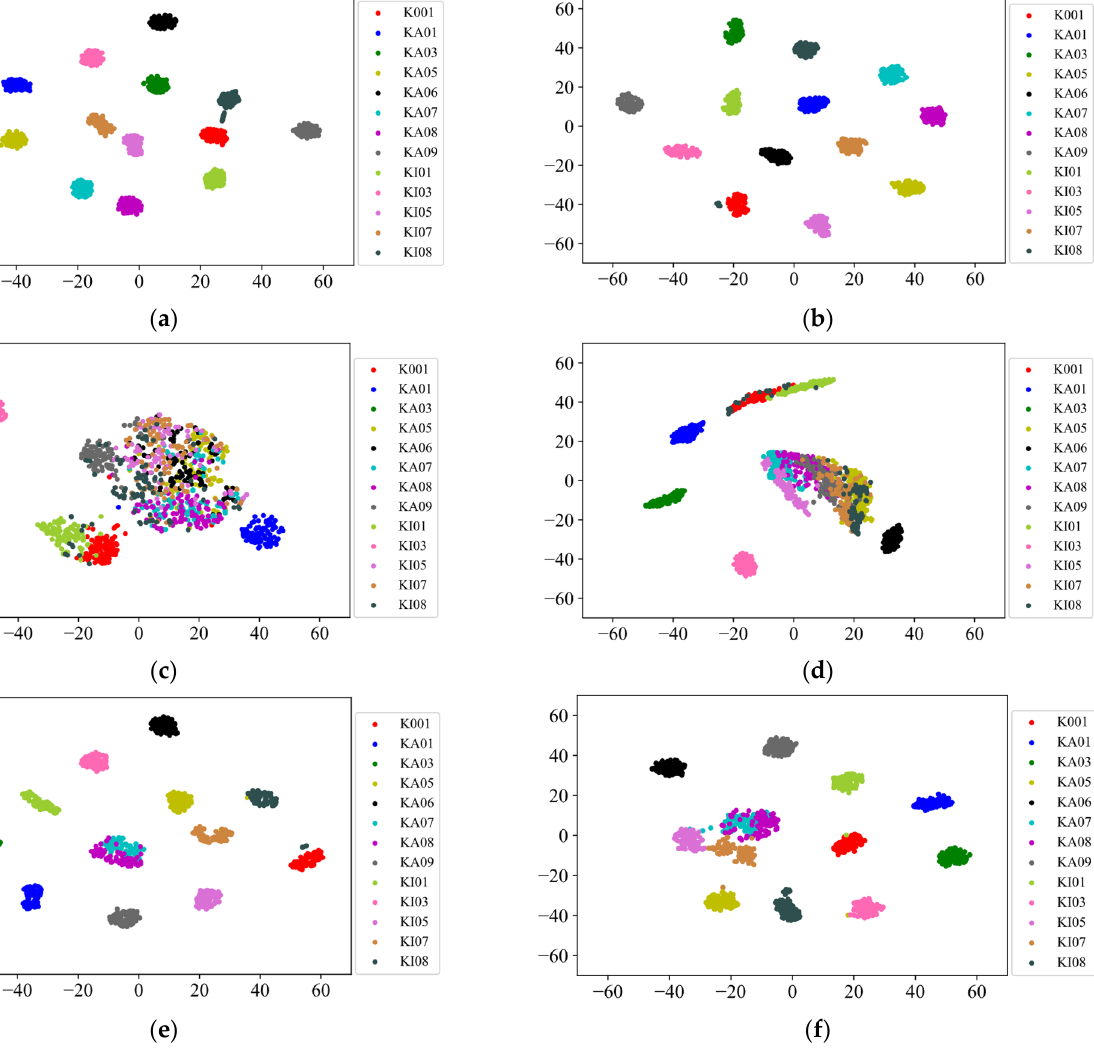
Figure 8. The visualization of feature extractors on unlabeled bearing dataset 1. ( a ) SMoCo; ( b ) labeled pretraining; ( c ) Wang; ( d ) SimCLR; ( e ) BYOL; ( f ) MoCo.